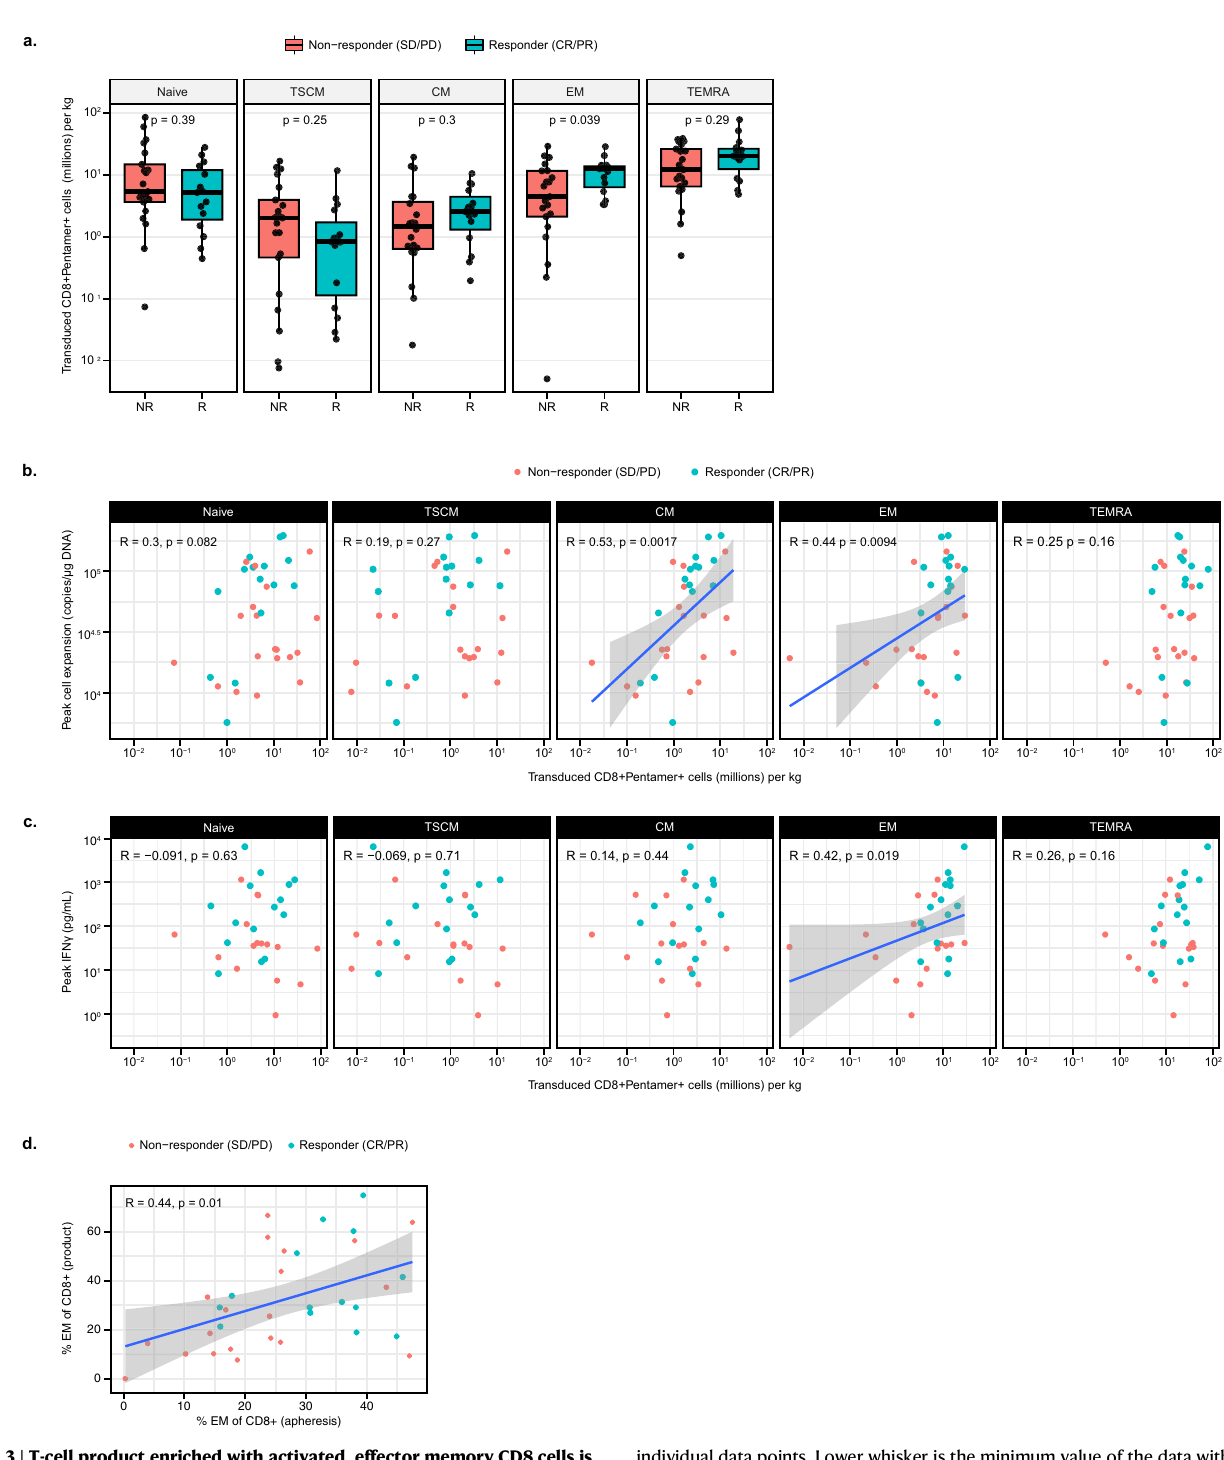
individual data points. Lower whisker is the minimum value of the data within 1.5 times the interquartile range below the 25th percentile. Upper whisker is the maximum value of the data within 1.5 times the interquartile range above the 75th percentile.Nominaltwo-sided p -valuesbasedontheWilcoxonranksumtestorlog- rank test for PFS are presented and correlations are based on Spearman method. Line of best fi t shown in blue for signi fi cant associations and gray area represents 95% con fi dence interval around the regression line. CM central memory